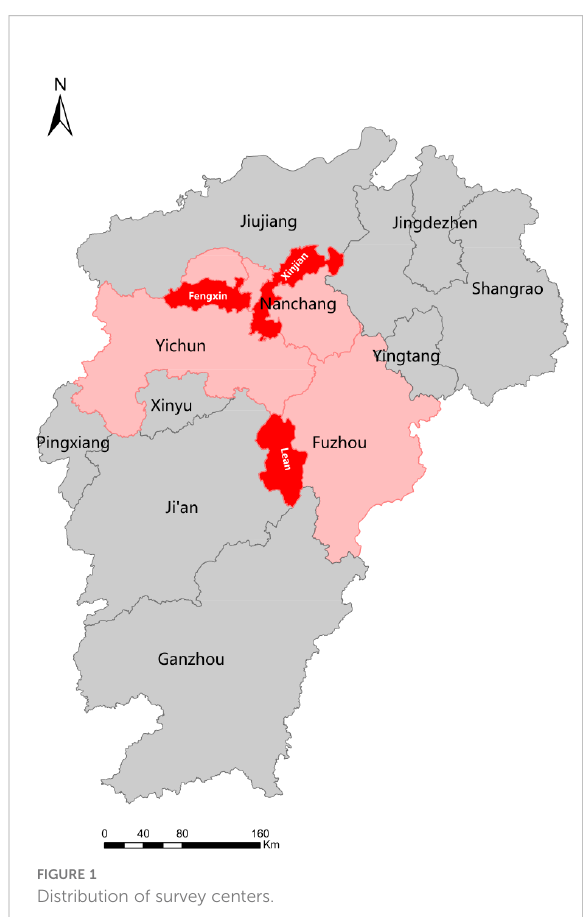
FIGURE 1 Distribution of survey